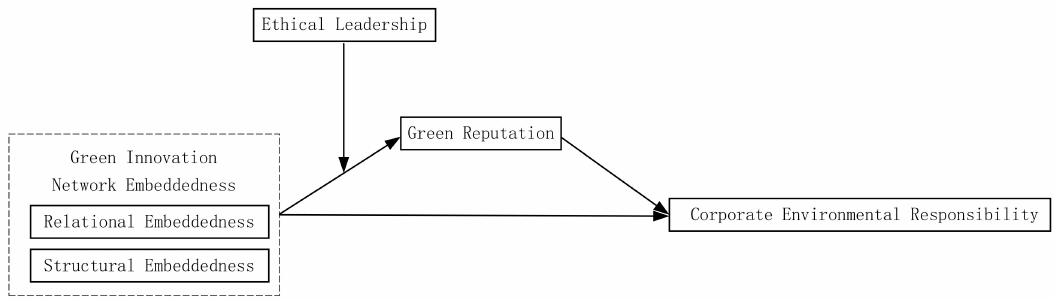
Figure 1. Hypothesized research